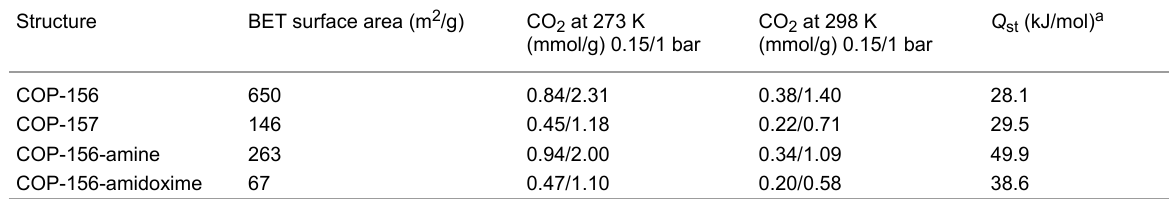
Table 1: BET surface area, CO 2 sorption properties at 273 K, 298 K and heat of adsorption values of all